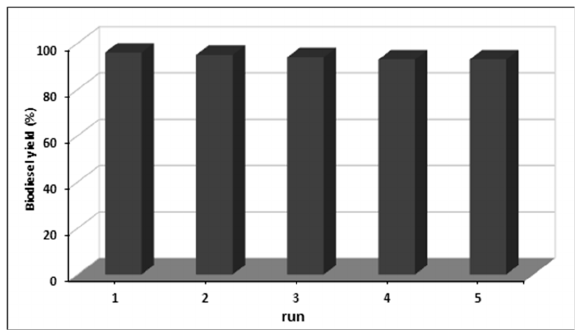
Figure 5. Recycling of the ZnO/TBAI catalyst system in the transesterification of soybean oil. Reaction